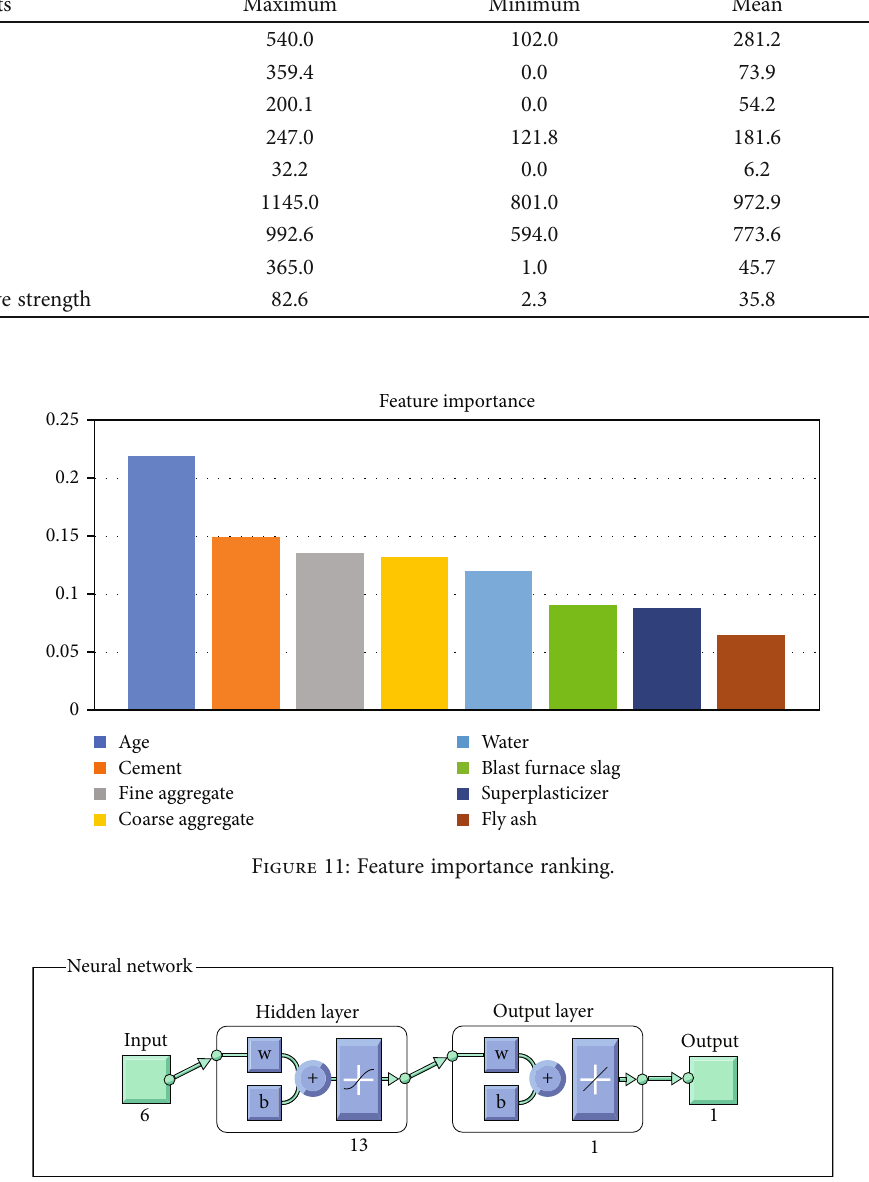
Figure 12: The basic structure of BP neural